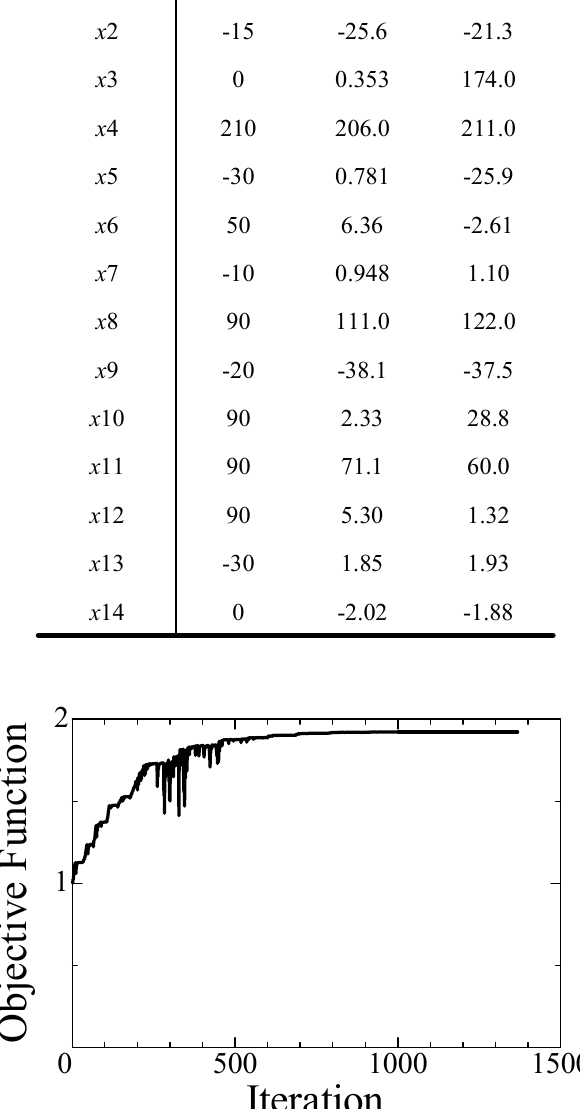
Fig. 11 History of objective function in